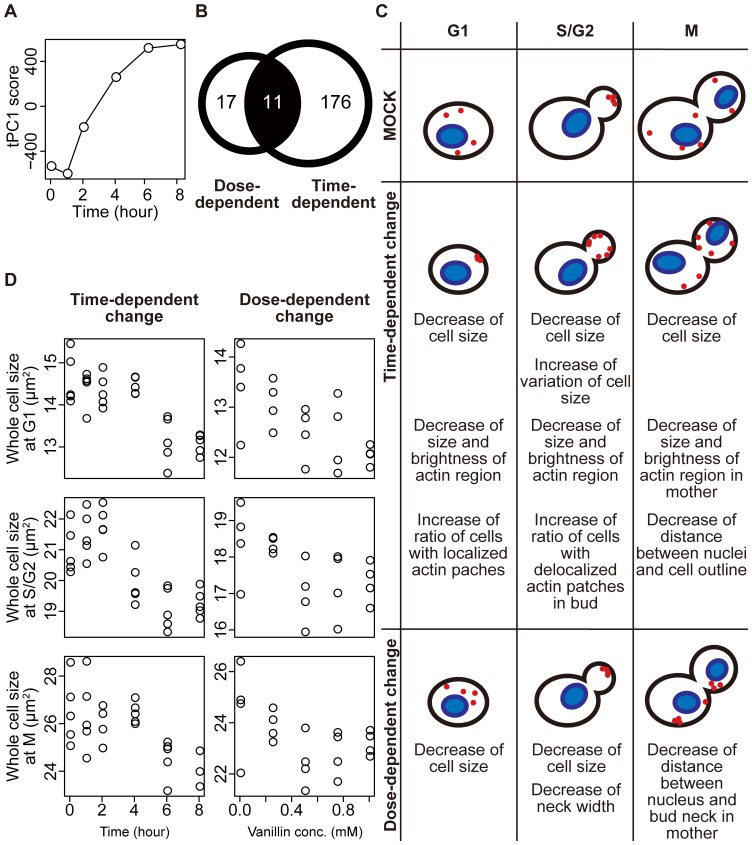
Morphological changes of yeast (Saccharomyces cerevisiae) cells after treatment with vanillin.(A) Time-dependent change in the tPC1 score. Wild-type (Δhis3 Δadh6) cells were pre-cultured in YPD medium, inoculated into YPD medium containing 4 mM vanillin at 1×106 cells/ml and incubated at 25°C. The cells were fixed at the indicated time points and stained with fluorescent dyes. Then, at least 200 cells were photographed under the fluorescence microscope and analyzed with CalMorph. For each parameter, the parameter values at each time point were summarized into one value from five replicate experiments with rank-order (see Materials and Methods) and subjected to PCA. The contribution ratio of tPC1 was 0.559. (B) Venn diagram of dose-dependent and time-dependent parameters after vanillin treatment. For dose-dependency, wild-type cells were grown in YPD medium containing 0.00, 0.25, 0.50, 0.75 and 1.00 mM vanillin. For time dependency, time-course data were acquired as described in (A). Of the 501 parameters, 28 and 187 were dose- and time-dependent, respectively, at P<0.01. The permutation tests determined that less than four and approximately four parameters were expected to be detected by chance at this P value, respectively. The parameters significantly changed in same direction (increase or decrease) were counted as the parameters changed similarly in both experiments. (C) Illustration of representative wild-type cells after vanillin treatment. In each dataset, the successive PCA [16] was performed to illustrate the representative cell shape. Blue filled ellipses and red circles indicate nuclei and actin patches, respectively. (D) Decrease in cell size after vanillin treatment. The parameter values of C11-1_A, C101_A1B and C101_C in each dataset were plotted for whole cell size in G1, S/G2 and M, respectively. For a full definition of the parameters, see [17].